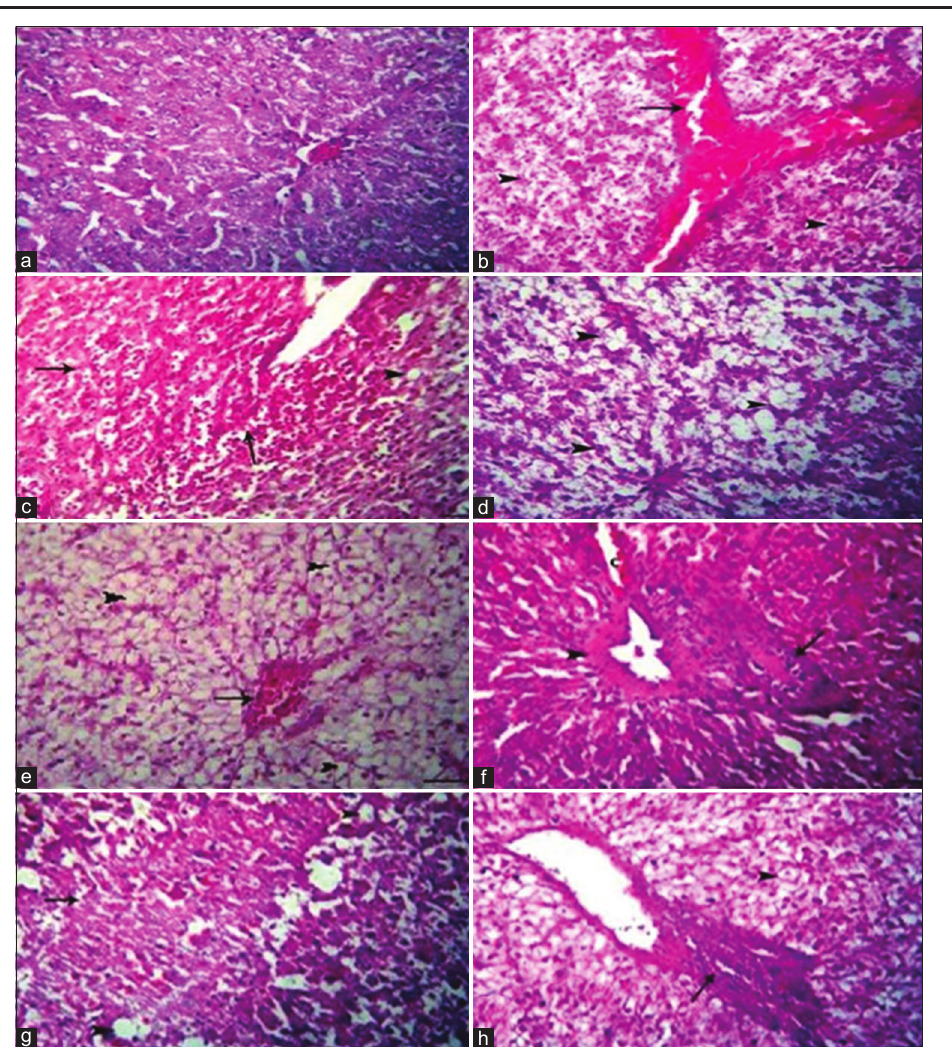
Figure-2: Liver from different groups: Control shows normal hepatocytes and sinusoidal architectures (a), Roundup shows severe congestion in hepatoportal blood vessels (arrow) (b), area of necrosis invaded with numerous leukocytes and erythrocytes (arrows) (c), and macrovesicular steatosis (d). Stomp shows congestion and severe hydropic degeneration and vacuolation in the hepatocytes (arrowheads) (e) and portal area with periductal fibrosis and round cells infiltration (arrow), and hyalinization in the wall of blood vessel (arrowhead) (f). Both Roundup and Stomp shows extensive coagulative necrosis (arrow) and perivascular edema (g) and aggregation of round cells in the portal area (arrow) (h). Hematoxylin and eosin × Scale bar = 25